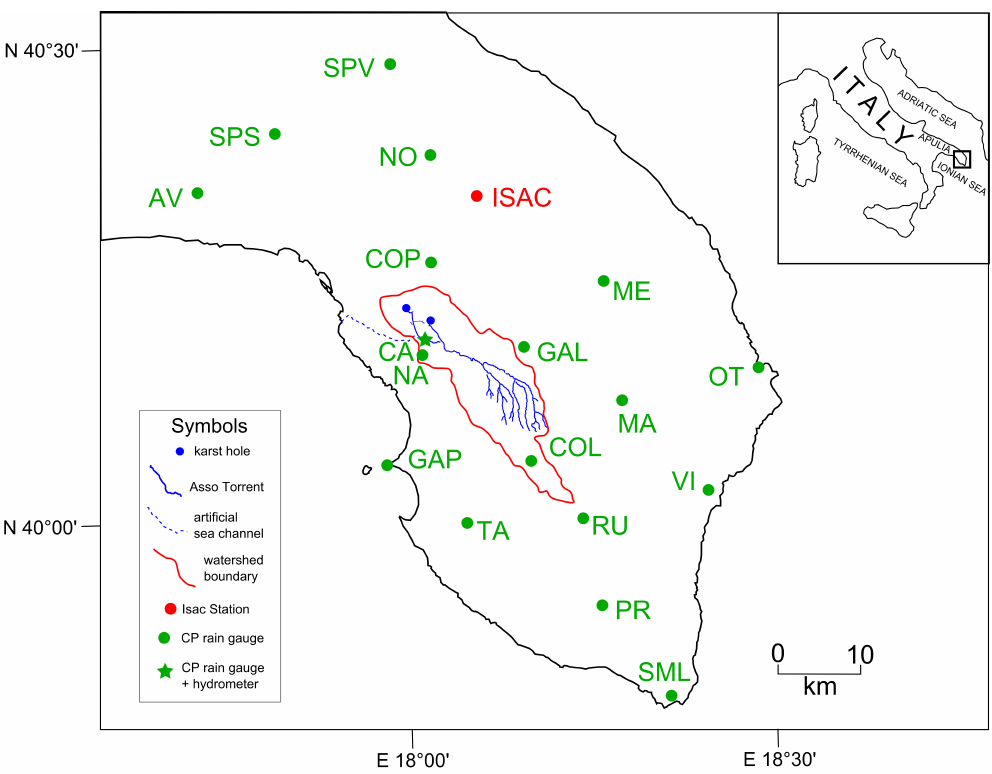
Figure 1. Map of Salento Peninsula and Asso Torrent basin; the measurement stations of the Civil Protection network are also shown (see the Abbreviations).